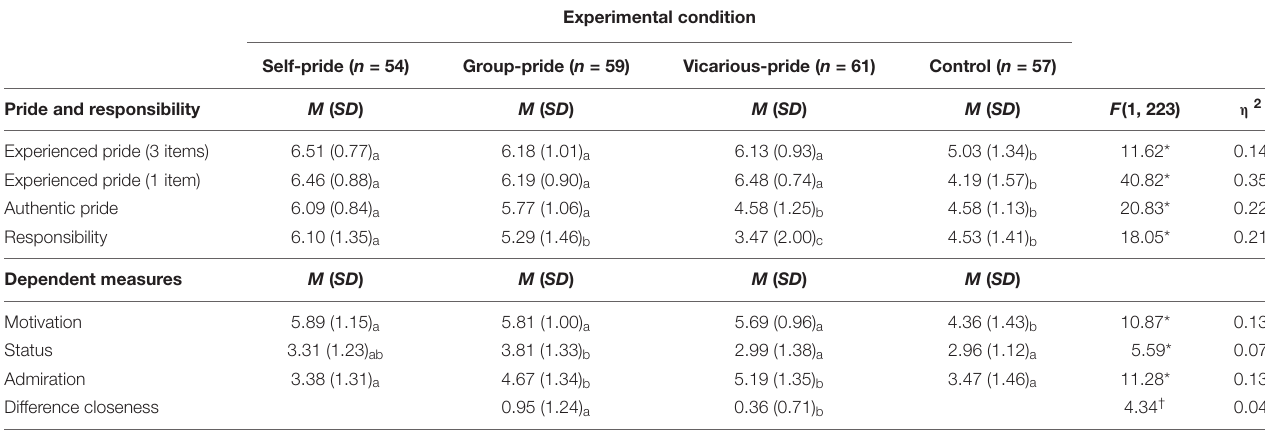
TABLE 1 | Means, standard deviations, and statistics of all dependent variables in Experiment